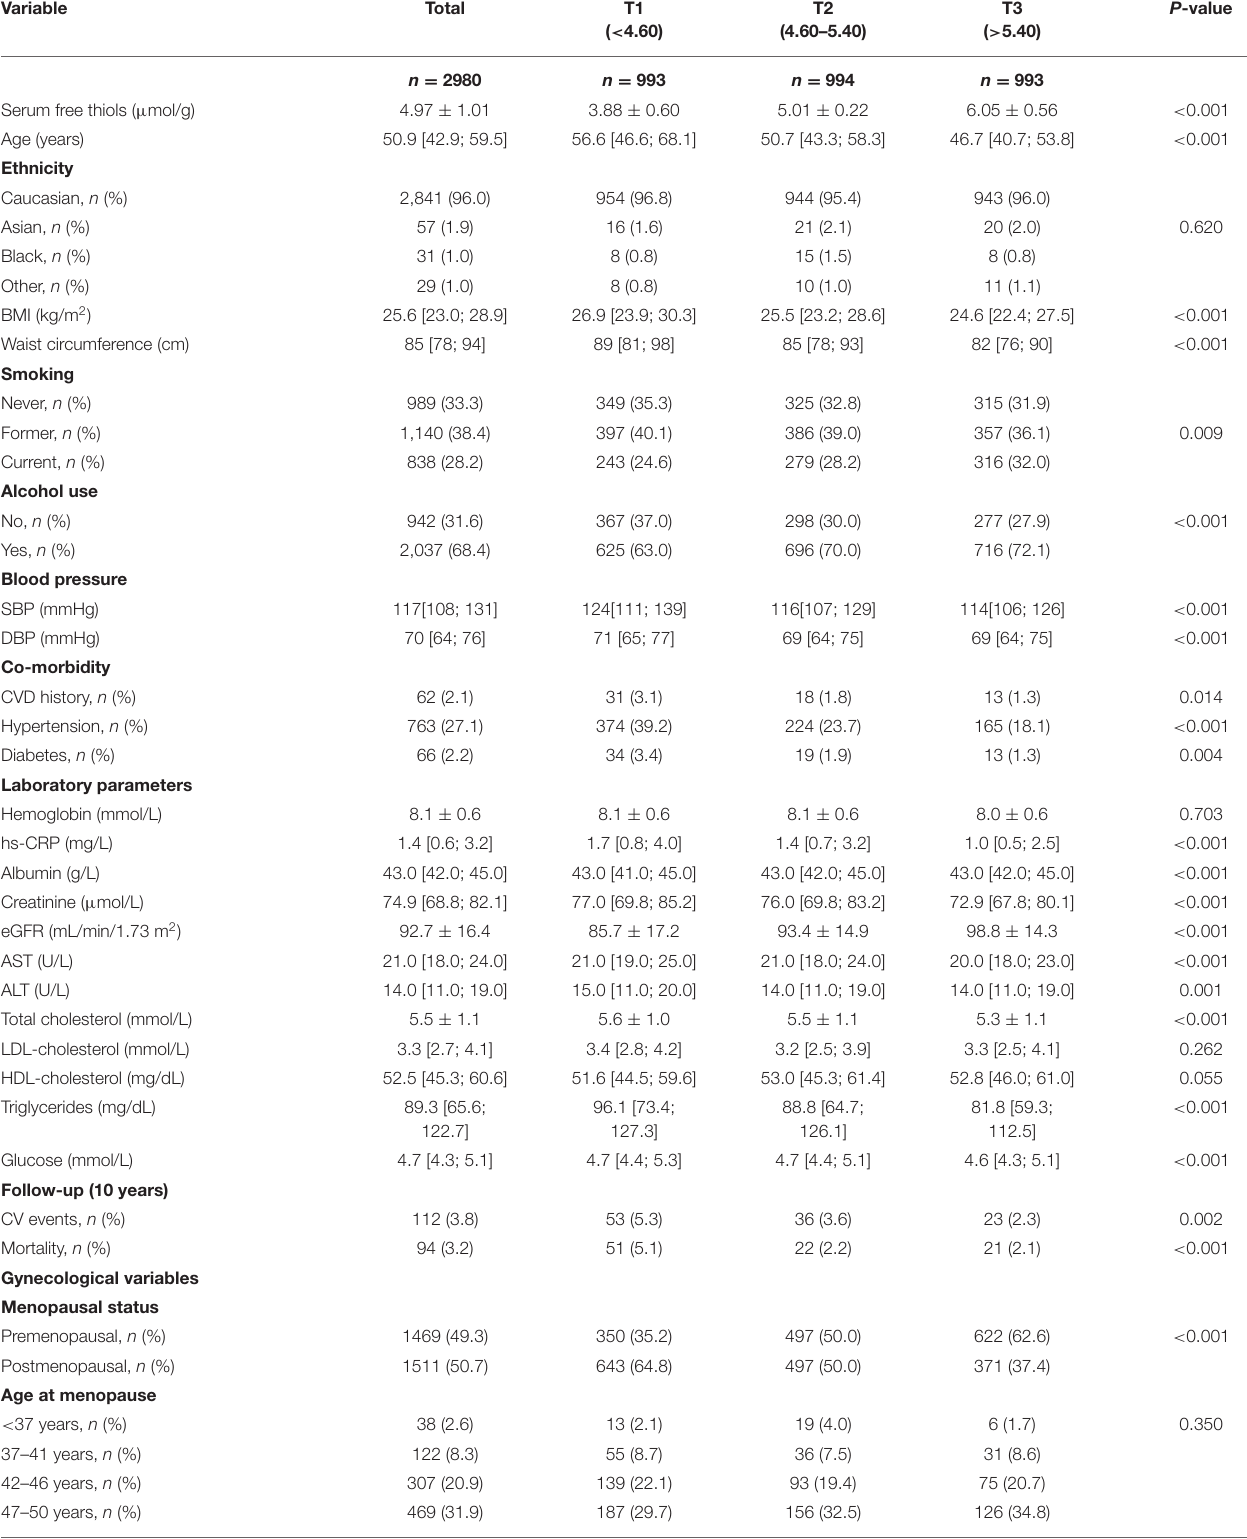
TABLE 1 | Baseline study population characteristics of women according to tertiles of serum free thiol concentrations ( µ mol/g).